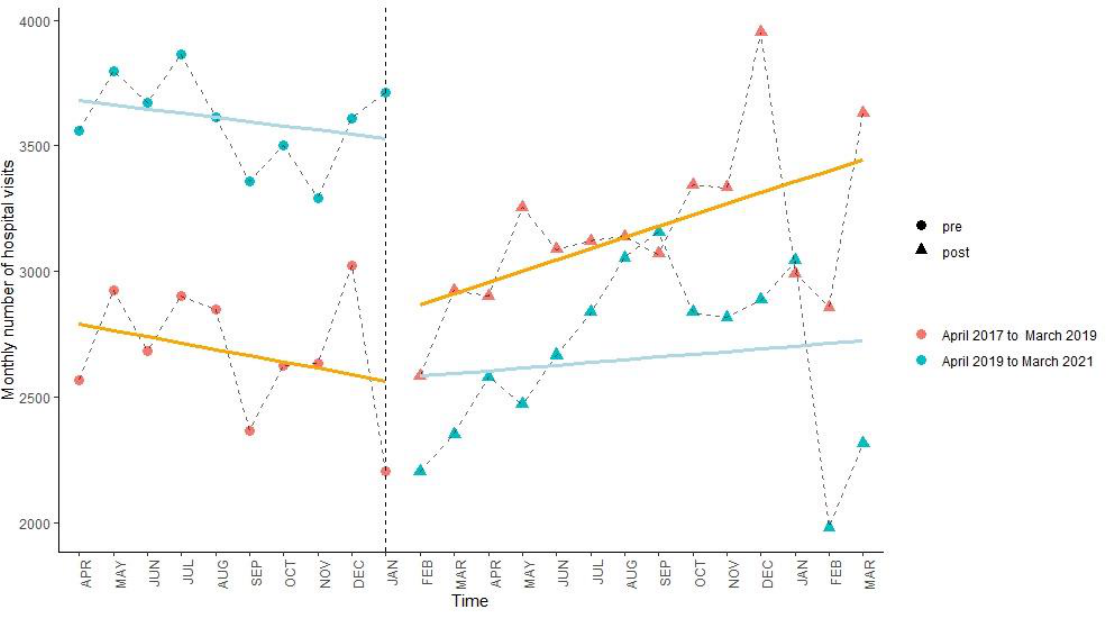
Figure 2. Interrupted time series analysis of hospital visits within Yangxi County from April 2017 to March 2019 (orange line) and from April 2019 to March 2021 (blue line). The line is the model fit and the vertical dashed line indicates the intervention (23 January 2020).